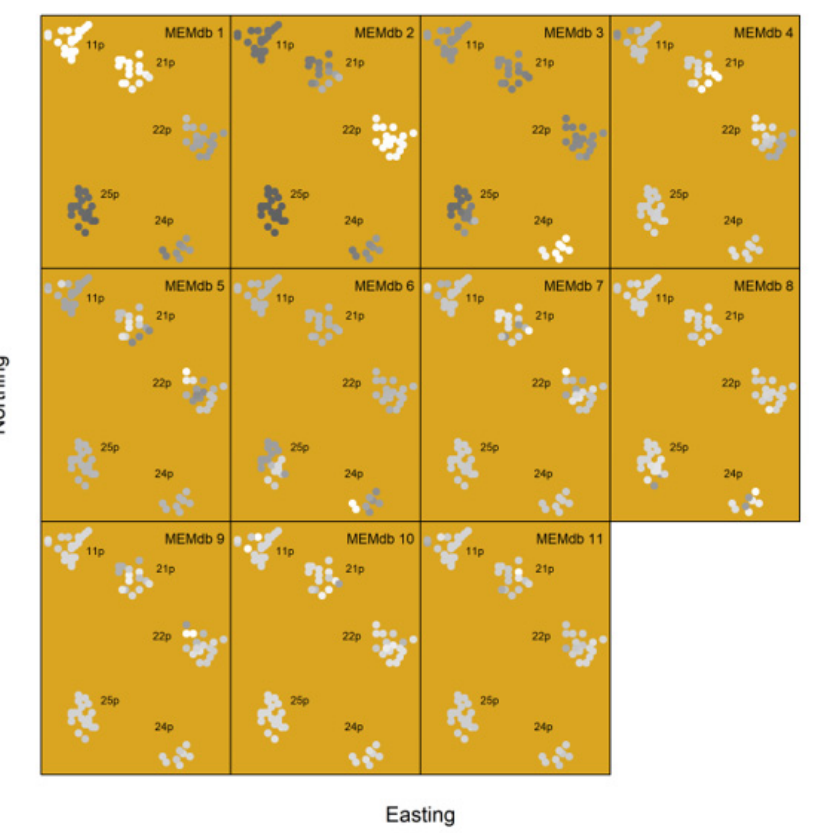
Figure 3. Moran eigenvector map weights projected onto spatial coordinates for seedlings (see Figure 1). Lighter grayscale colors indicate larger positive loadings for seedling coordinates in ei- genvectors. Table 3. Results of vector (quantitative variables) and factor (categorical) fitting to the NMDS pro- jection (Figure 4), 999 permutations used. Statistically significant results are shown in boldface type.